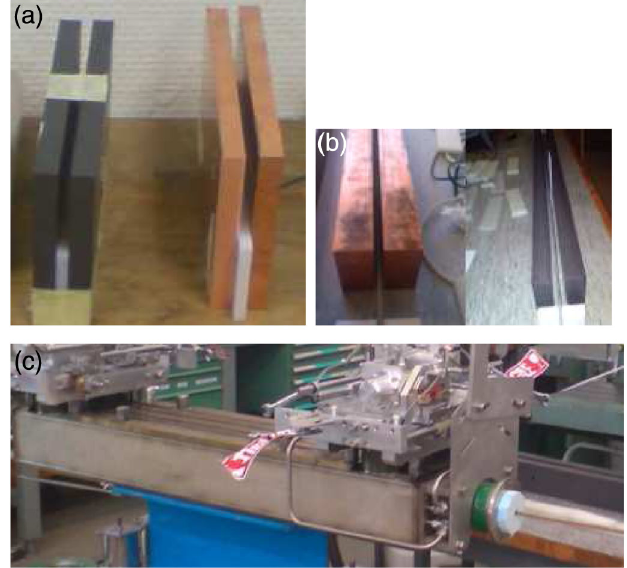
FIG. 8. (Color) Pictures of the three measurement setup stages: (a) sample plates 15 cm (cid:5) 10 cm (cid:5) 1 cm , (b) stand-alone jaws 120 cm (cid:5) 10 cm (cid:5) 2 : 5 cm , and (c) collimator assembly (jaws 120 cm (cid:5) 10 cm (cid:5) 2 : 5 cm ).